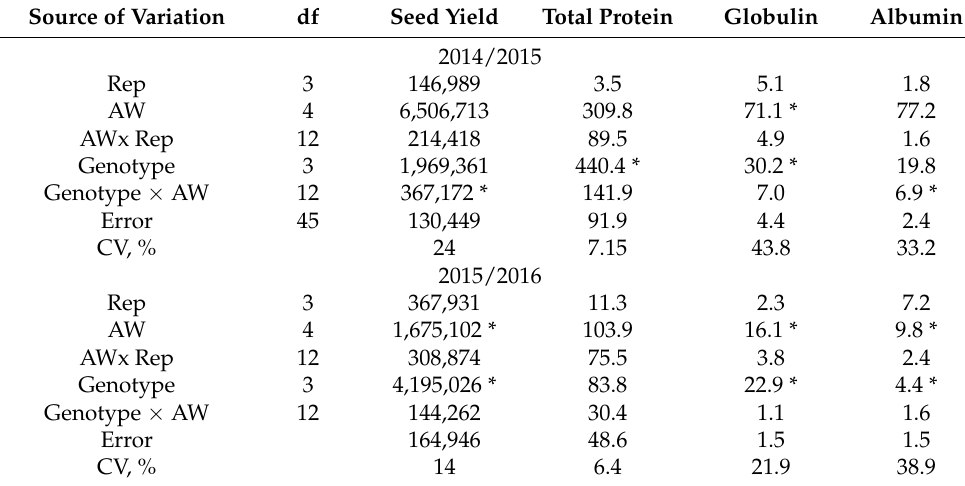
Table 2. Mean square values for seed yield, protein, globulins, and albumins for the analysis of variance in seasons 2014/2015 and 2015/2016.